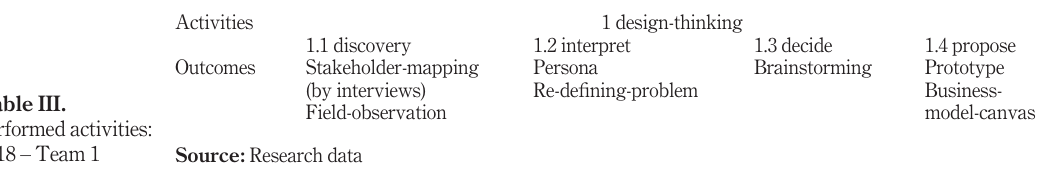
Table III. Performed